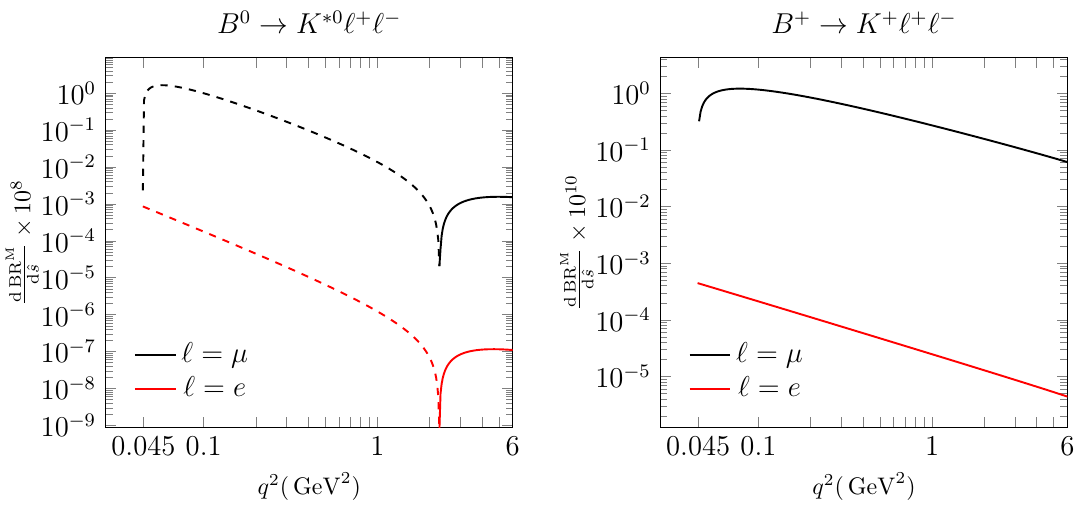
Figure 3 . Di(cid:11)erential distributions of branching ratios as in (cid:12)gure 2 for the pure magnetic- dipole corrections, as a function of q 2 . Left and right plots correspond to the B ! K (cid:3) ‘ + ‘ (cid:0) and B ! K‘ + ‘ (cid:0) decays respectively. In the left plot, where the absolute value of the distribution is plotted, values of the curves for q 2 less (greater) than the dip point (at q 2 (cid:24) 2 GeV 2 ) are negative (positive) respectively. Distributions at the dip point are understood to